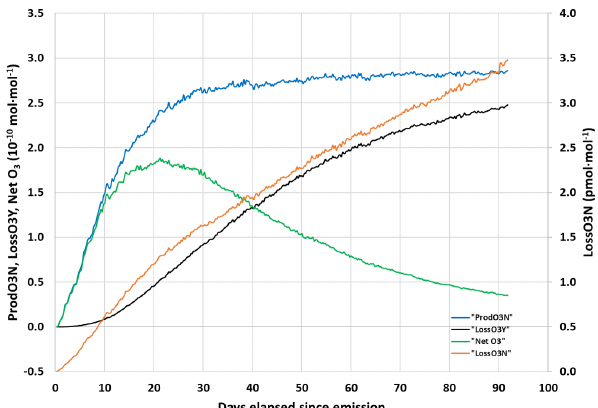
Figure B1. Time evolution of O 3 production and loss terms for